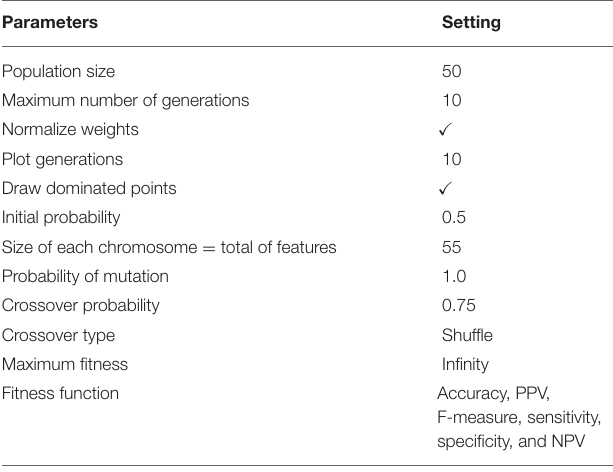
TABLE 5 | The parameters setting of the genetic optimization algorithm.